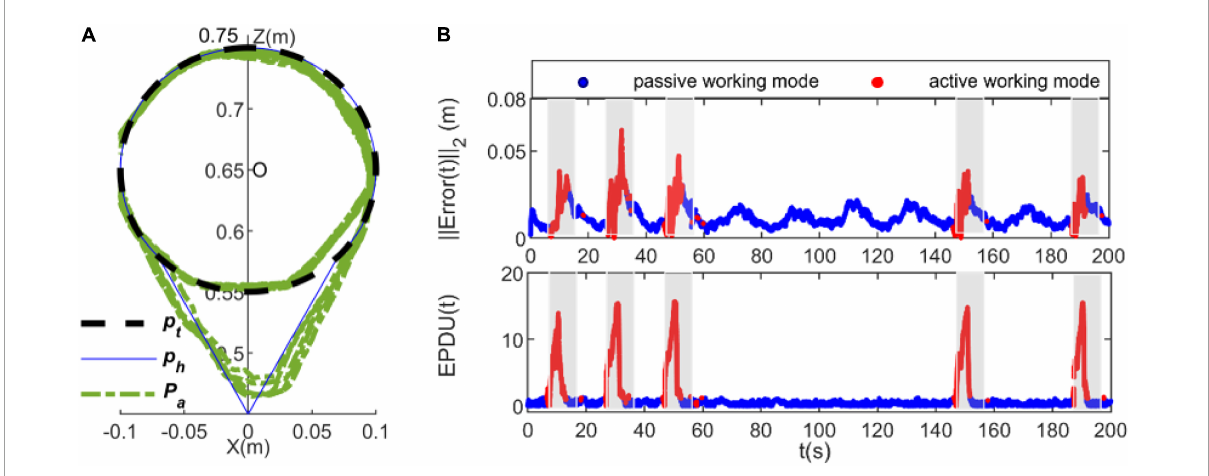
FIGURE7 Experimental results of the proposed traditional admittance control (TAC) strategy measured from subject 2. (A) Tracking trajectories, (B) tracking error and EPUD(t). The shadows in each subplot indicate the time duration of appearance of the unpredicted obstacle and the intervention required from the participant to bypass it. The deep blue scatterplot shows the results of the passive working mode, and the red scatterplot shows the results of the active working mode.